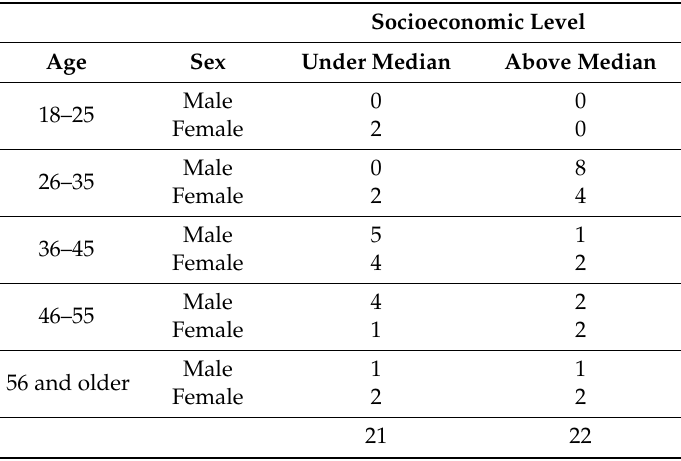
Table 1. Participant’s